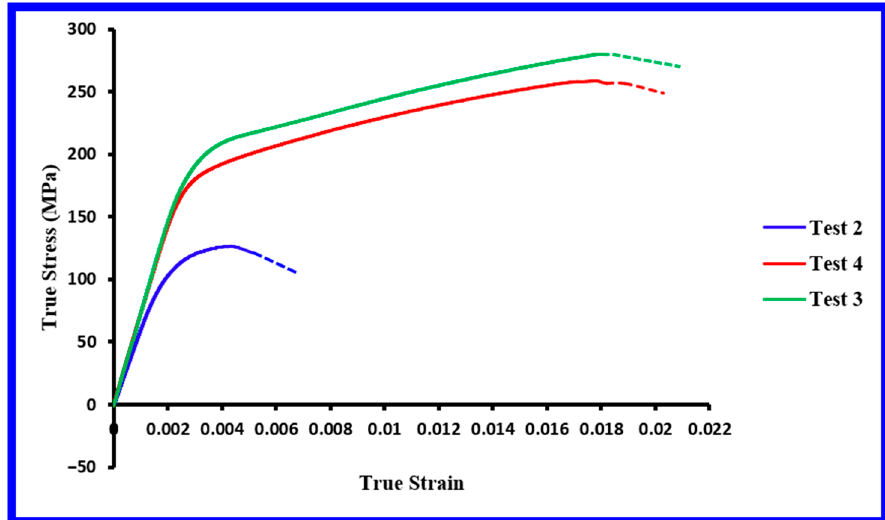
Figure 17. Stress–strain curves for modification of the material behavior in the welded zone.